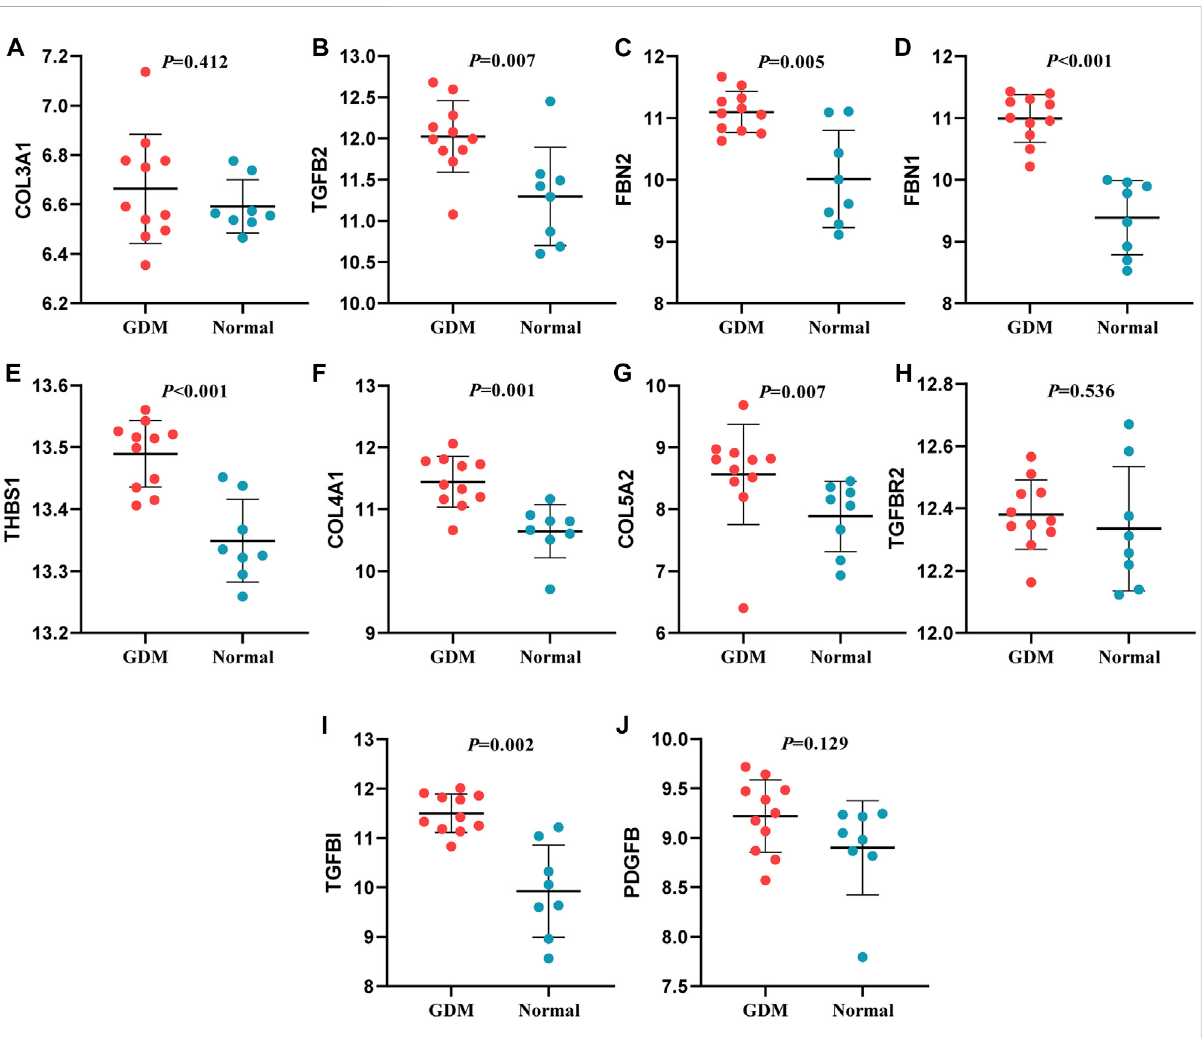
FIGURE 8 Veri fi cation of up-regulated genes. (A) : COL3A1 (B) : TGFB2 (C) : FBN2 (D) : FBN1 (E) : THBS1 (F) : COL4A1 (G) : COL5A2 (H) : TGFBR2 (I) : TGFBI (J) :